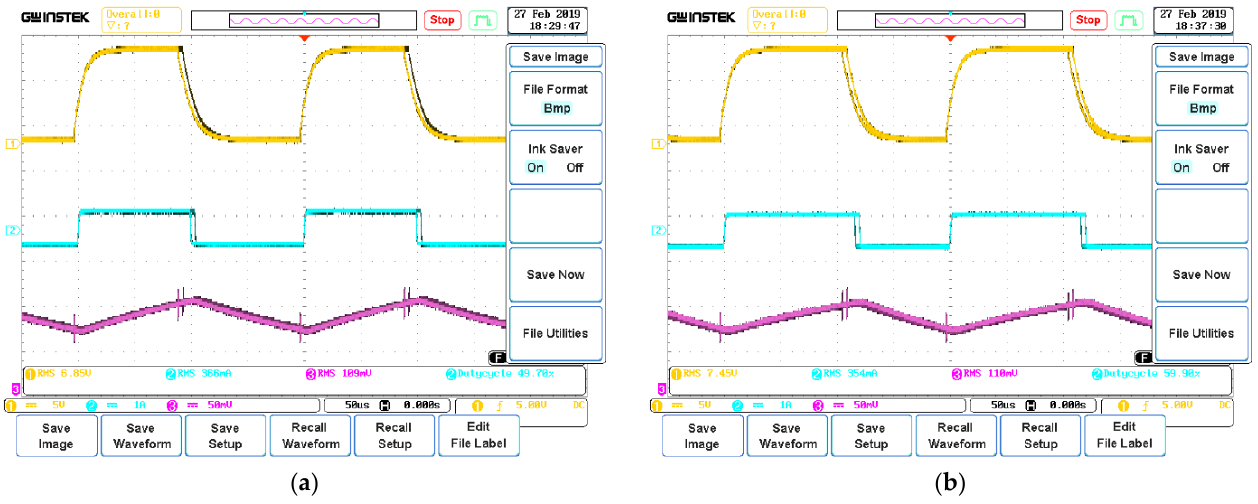
Figure 12. Waveforms of voltage V GS , drain current I D , sensor voltage E 1 of the system with the Ring XRE module at E zew = 200 lx ( a ) and E zew = 100 lx ( b ). In this case, the system behaves in the same way as the system with the XML2 power LED. The increase in external illuminance is the same as the decrease in the value of the duty cycle d of the control signal, and the decrease in the RMS value of the current flowing through the Ring XRE module. On the other hand, the RMS value of the voltage on the photodetector changes only insignificantly. The values of the obtained electrical and op ‐ tical parameters of the tested system are presented in Table 5. Table 5. Values of electrical and optical parameters for selected values of external illuminance for the system with the Ring XRE module. E zad (lx)